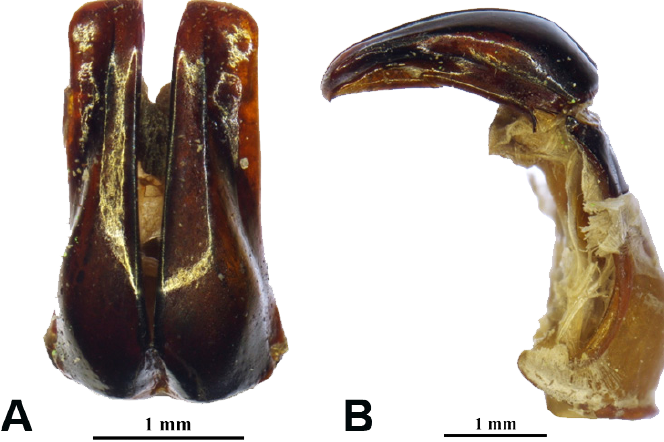
Fig. 2. Neoclita pringlei gen. et sp. nov., holotype, ♂. A . Aedeagus, dorsal view. B . Aedeagus, lateral view. (South Africa, Eastern Cape Province, Matatiele Nature Reserve, 6 Dec. 2008, R. Perissinotto